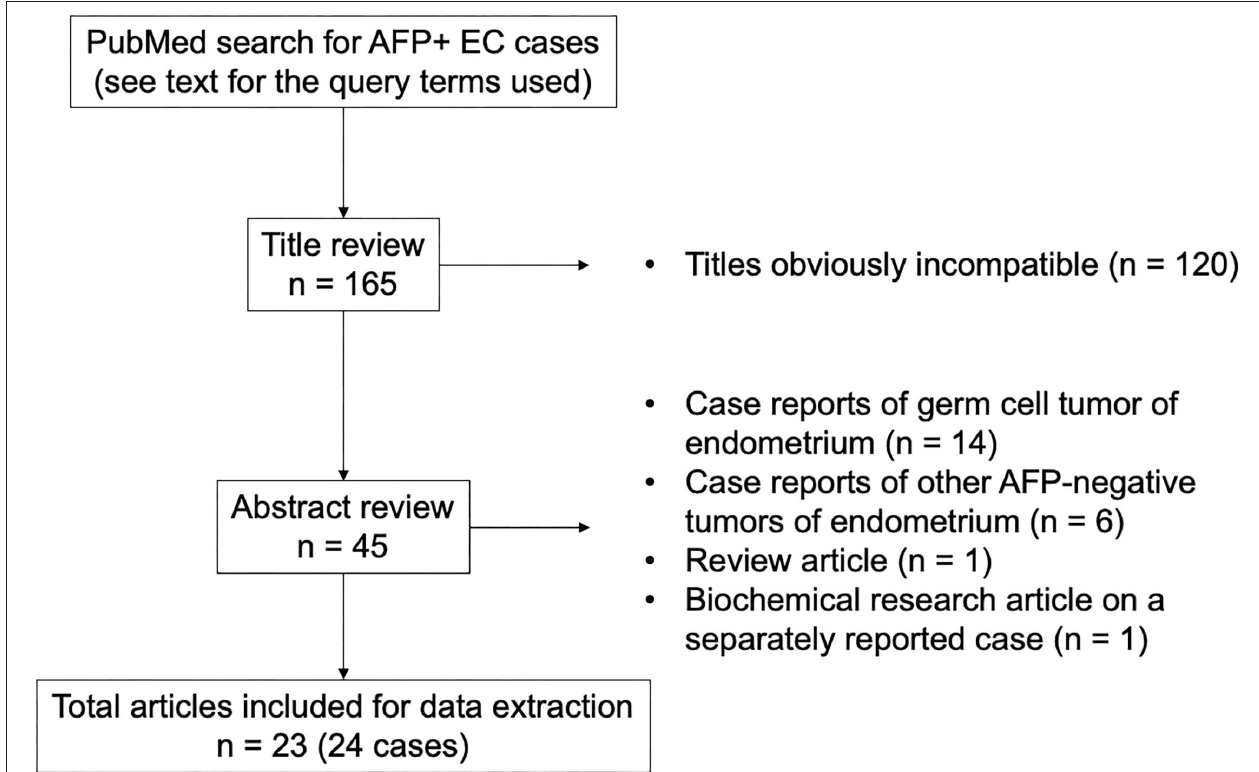
FIGURE 1 | Selection of reported